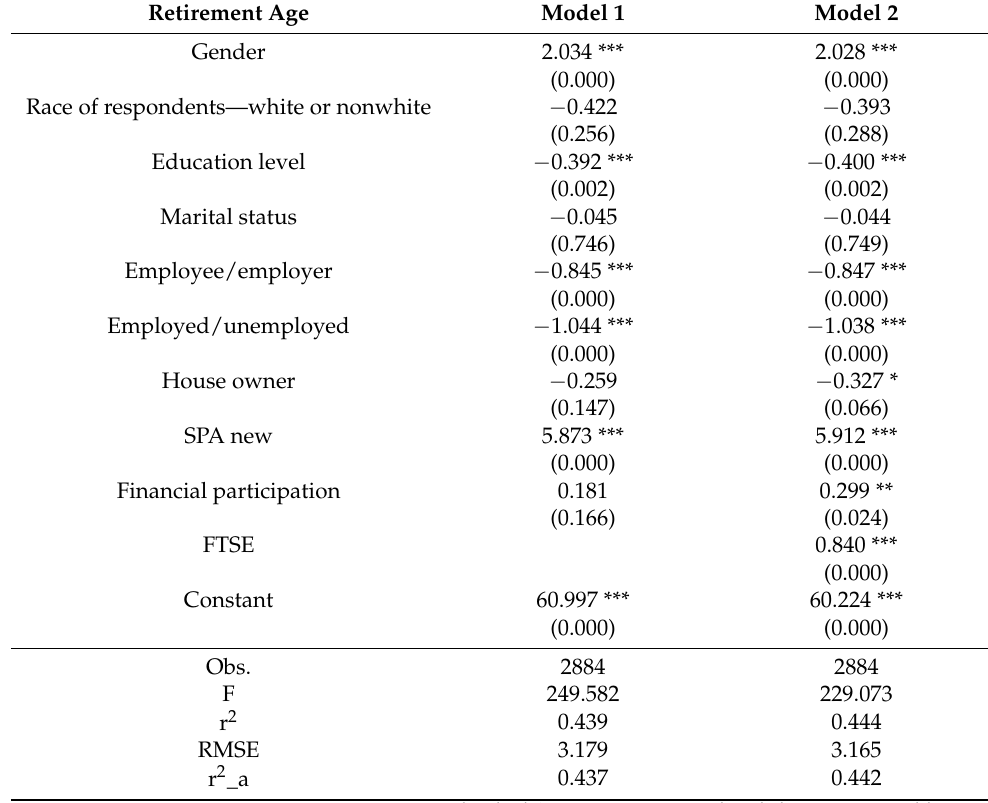
Table 2. Regression for the retirement